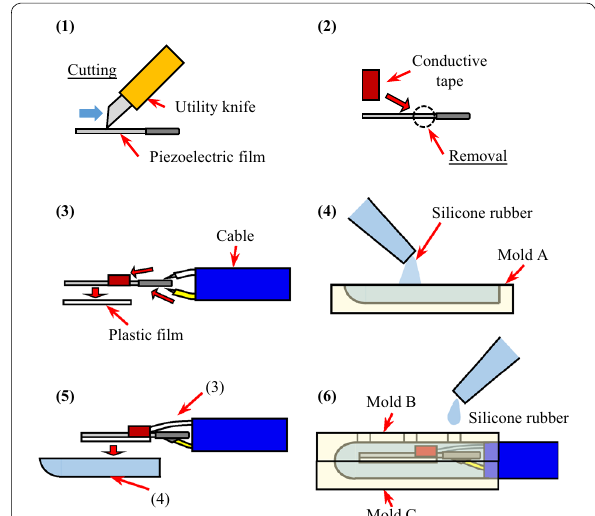
Fig. 4 Fabrication process of the prototype